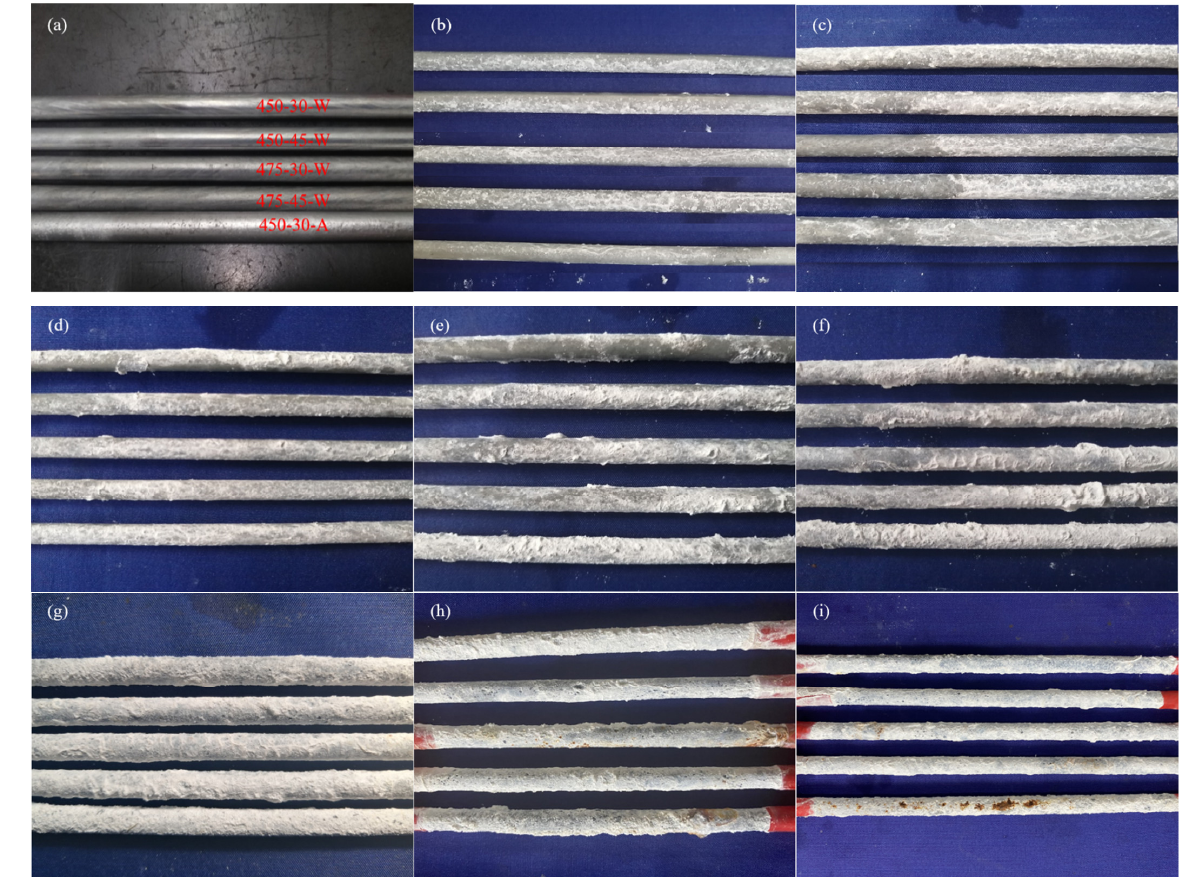
Figure 8. Macroscopic morphology of hot dip coated steel wire with different process parameters after different times of salt spray corrosion, ( a ) before the test; ( b ) 24 h; ( c ) 20 d; ( d ) 40 d; ( e ) 60 d; ( f ) 80 d; ( g ) 100 d; ( h ) 120 d; ( i ) 150 d.